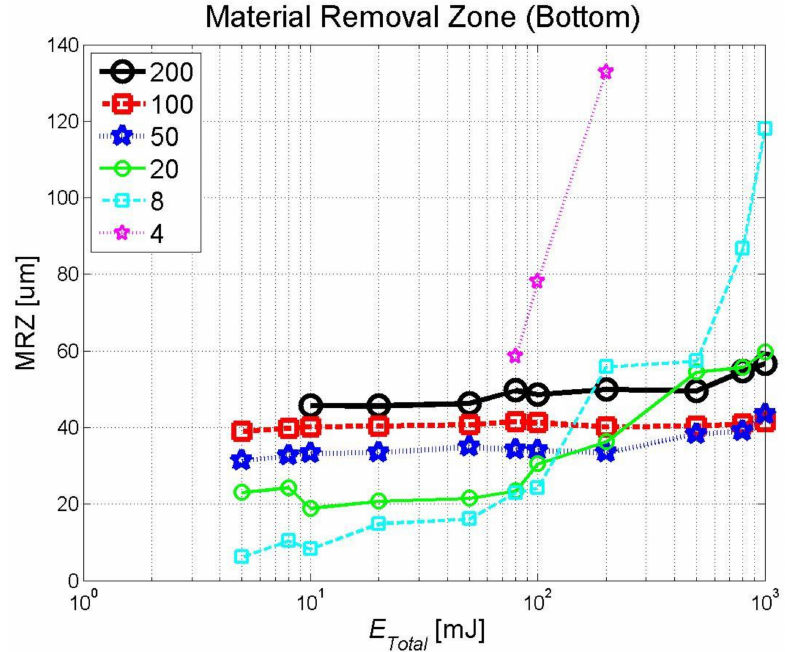
Figure 6. Material removal zone (Bottom) with the pulse duration from 4 ns to 200